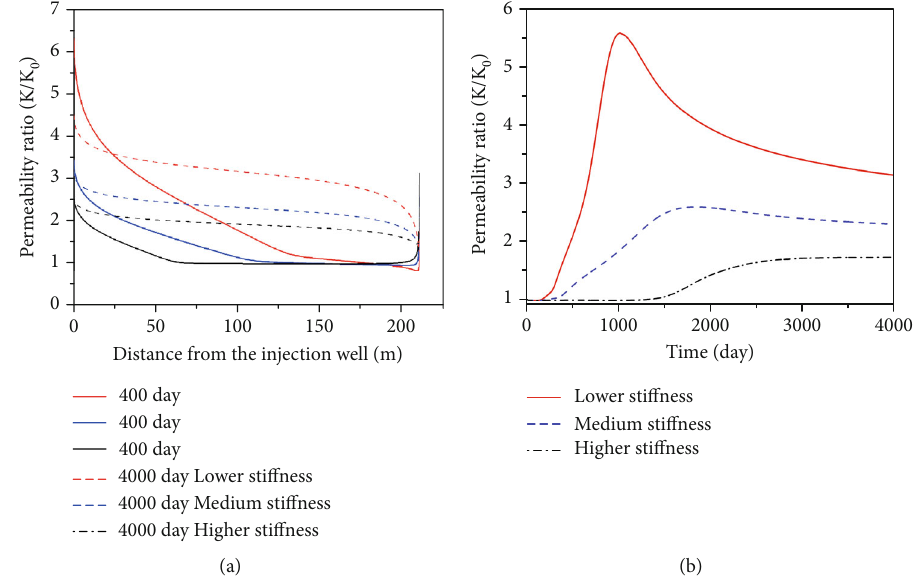
Figure 14: Permeability evolution within CBM reservoir during N (b) Evolution of permeability ratio at reference point